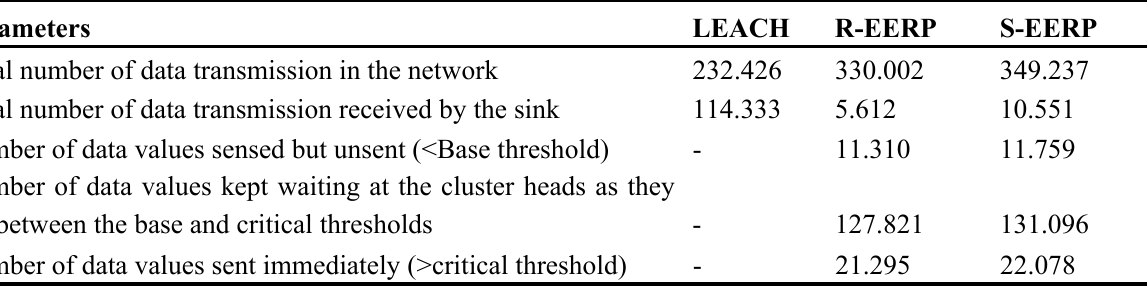
Table 3 . Total number of data transmission at the whole network and received at the